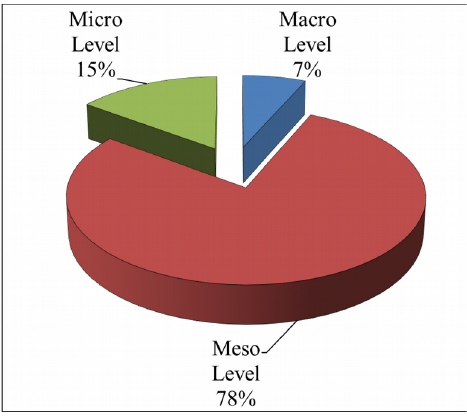
Figure 6. Scope level of MSC